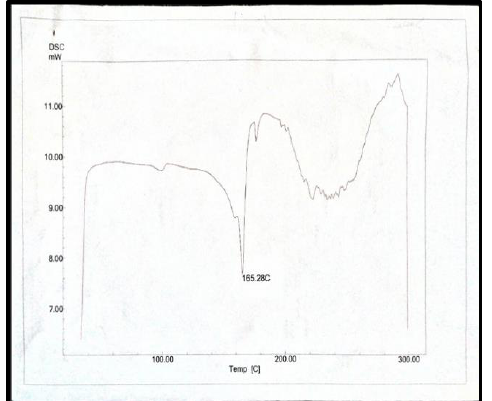
Figure 12. (B) DSC thermogram of atorvastatin calcium pure powder. Formulation F18 containing TPGS/Tween80 was chosen for scanning electron microscope examination, images at figure 13 (A and B ) demonstrates clear crystal shape and morphology. The same results of crystal nature appeared on XRD and DSC that referred to crystal form of the yielded powder.